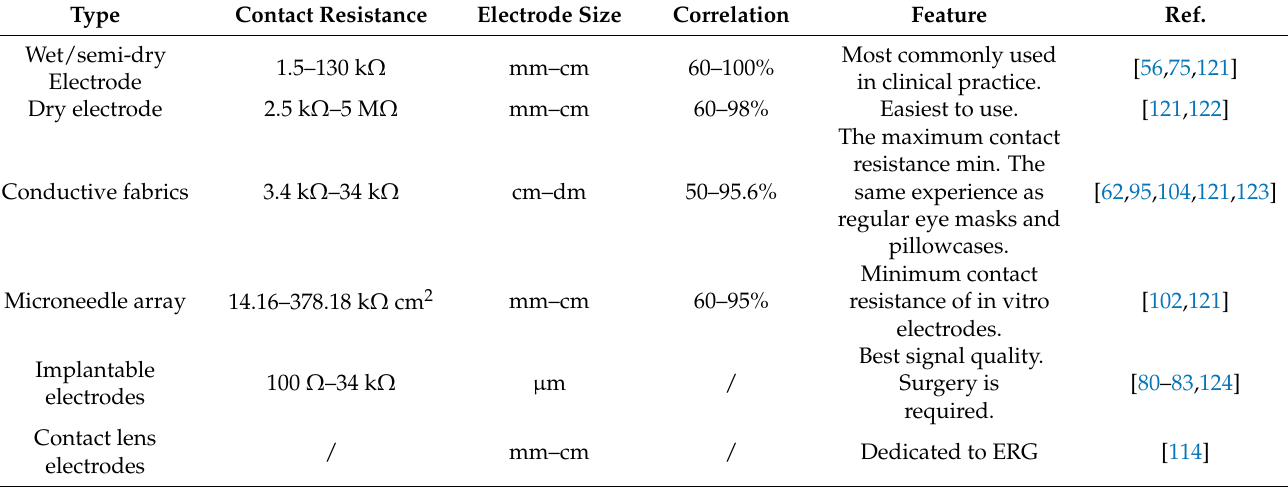
Table 1. Table of electrodes for bioelectrical